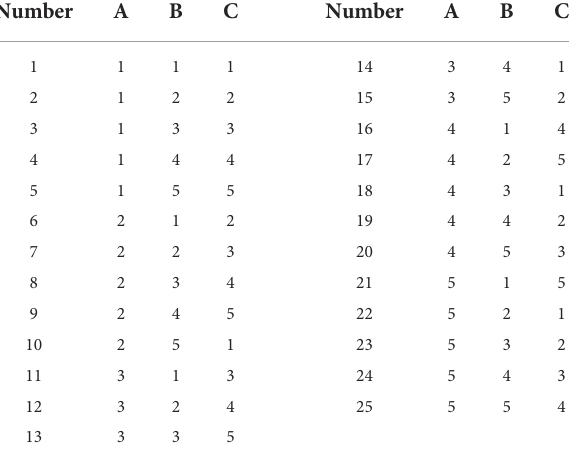
TABLE 6 Composition of functional soil additives by an orthogonal test. Number